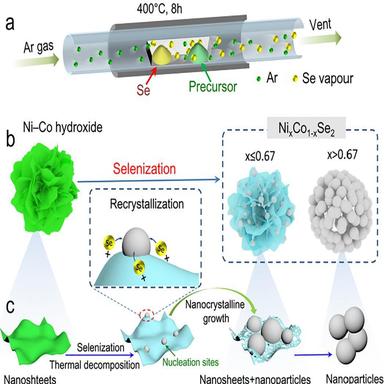
(a and b) Schematic of the low-temperature selenization process of the Ni–Co selenides, and (c) schematic of the selenization and structure conversion mechanisms of the Ni–Co selenides.